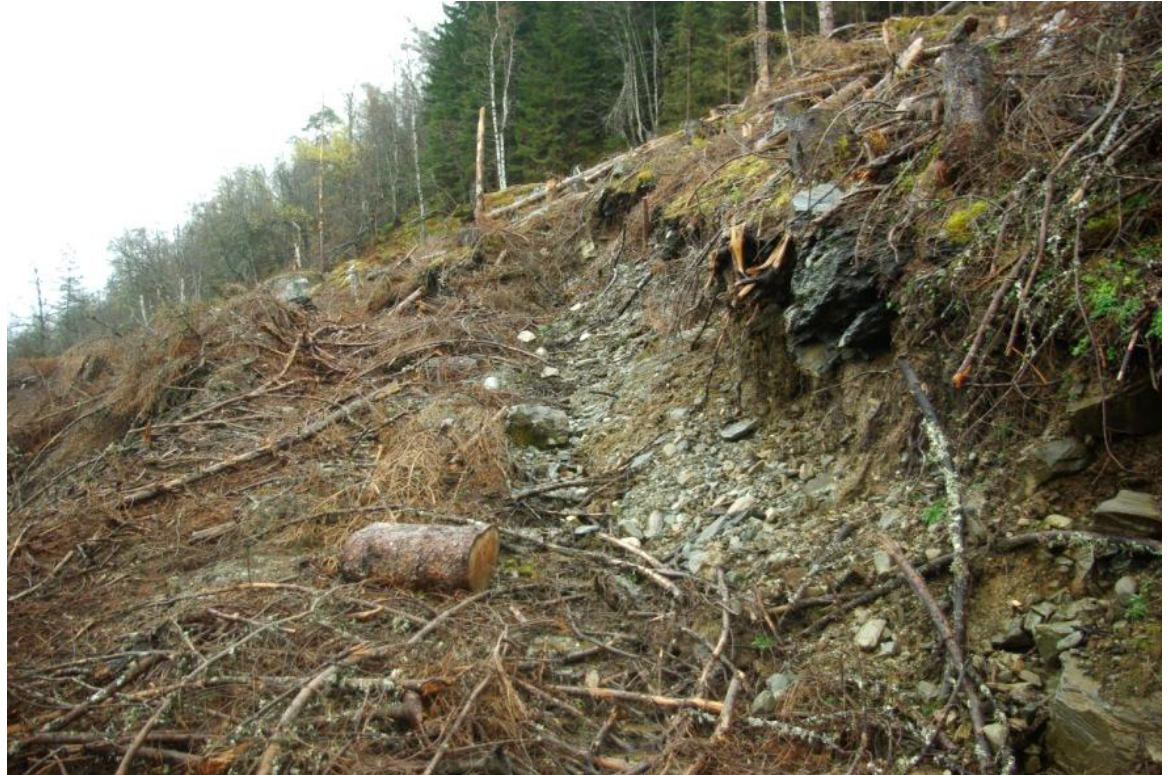
Figure 1. Image of one of the skid trails, indicating how the material on the cut bank was already collapsing to a natural angle of repose by the time of the